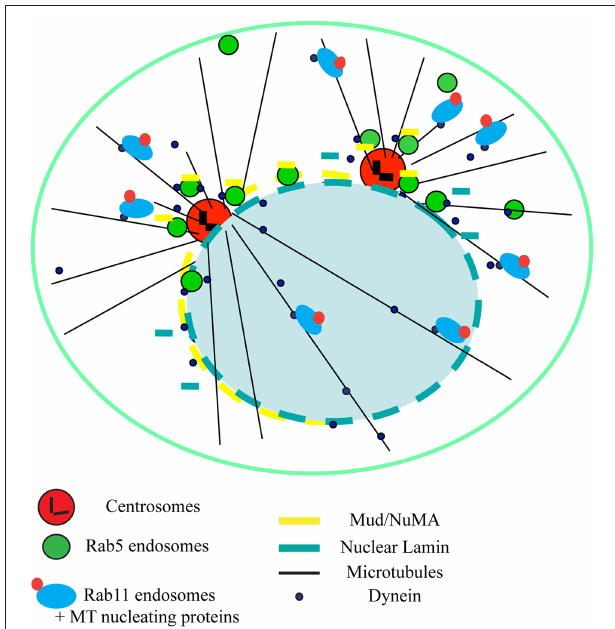
FIGURE 1 | Novel mitotic roles of Rab5 and Rab11 endosomes. Schematic diagram illustrating the roles of Rab5 and Rab11 endosomes in binding and trafficking important mitotic proteins via dynein-mediated transport in prophase. In addition, is noteworthy that, during metaphase, Rab5 vesicles also move along spindle microtubules and transport CENP-F to kinetochores (not shown). See text for details.